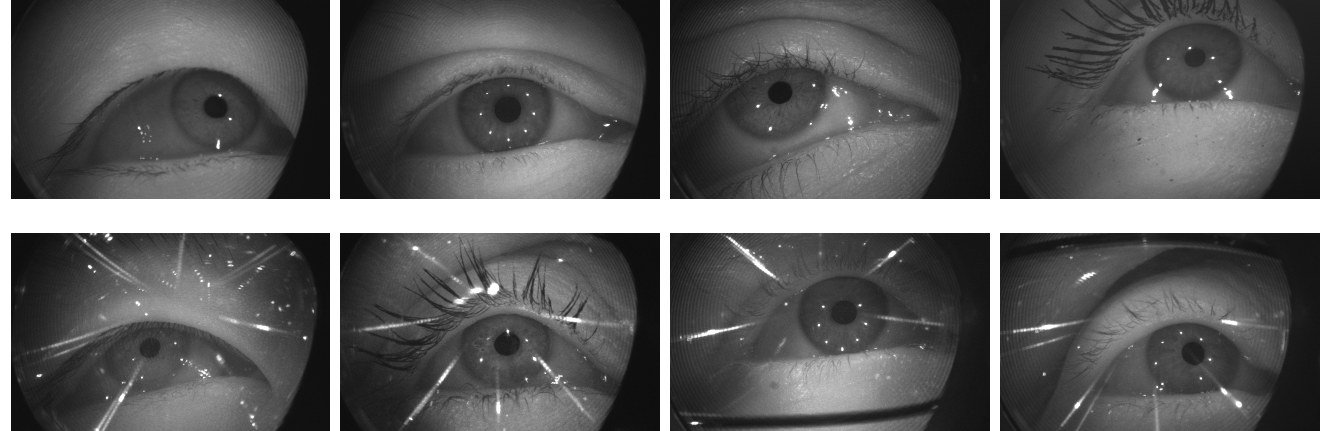
Figure 1. Examples of images without glasses ( top row ) and with glasses ( bottom row ), representing the variability of the dataset in terms of accessories, ethnicity, age and